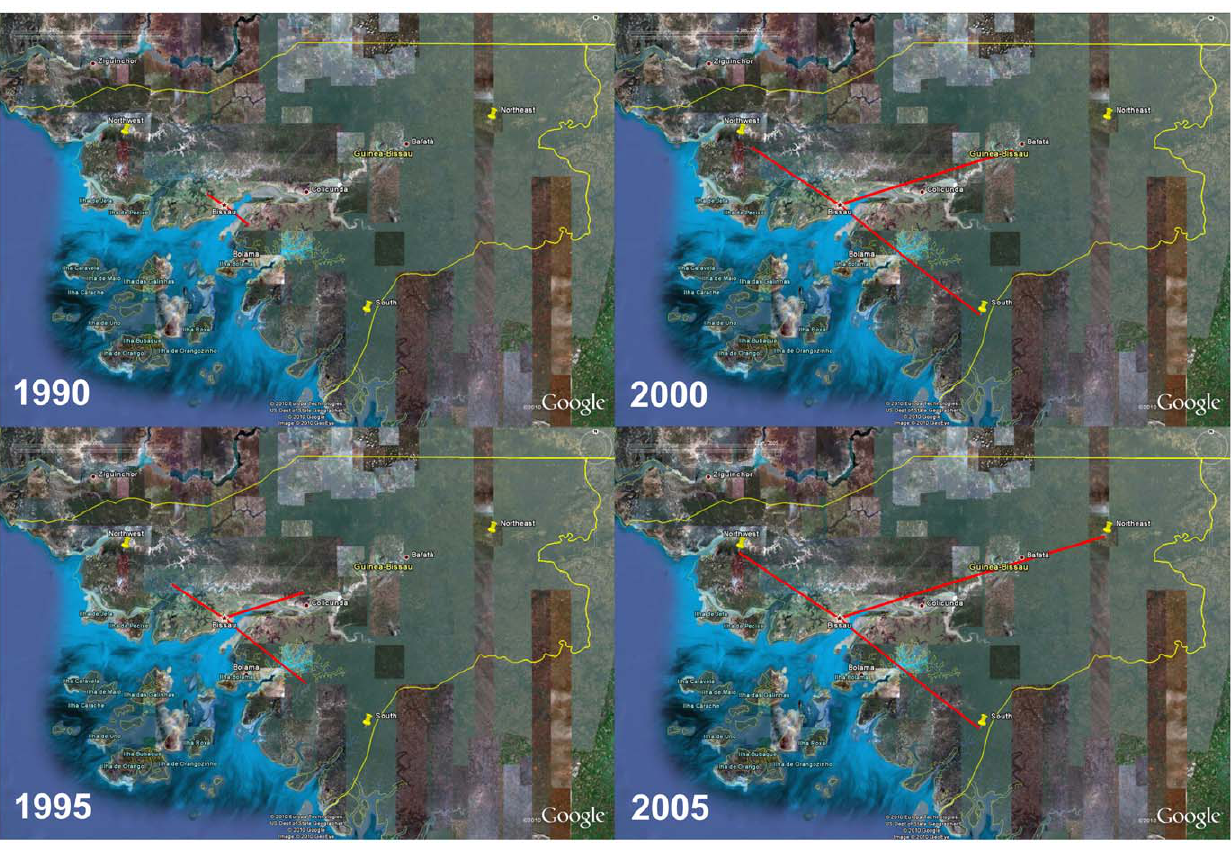
Figure 5. Temporal dynamics of spatial HIV-1 subsubtype A3 diffusion within Guinea-Bissau. Snapshots of the HIV-1 subsubtype A3 dispersal pattern within Guinea-Bissau. Lines between locations represent branches in the maximum clade credibility tree (MCC) along which well- supported location transitions occurs. The diffusion process was visualized in Google Earth (http://earth.google.com).